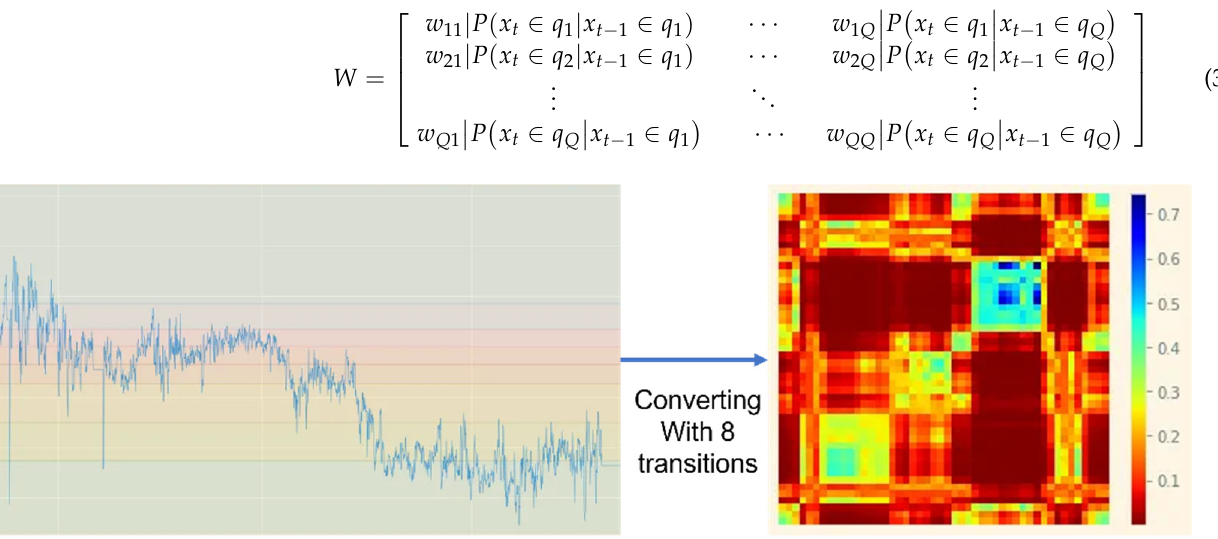
Figure 5. Example of transforming the serialized data to the corresponding image based on MTF with eight-level transitions.